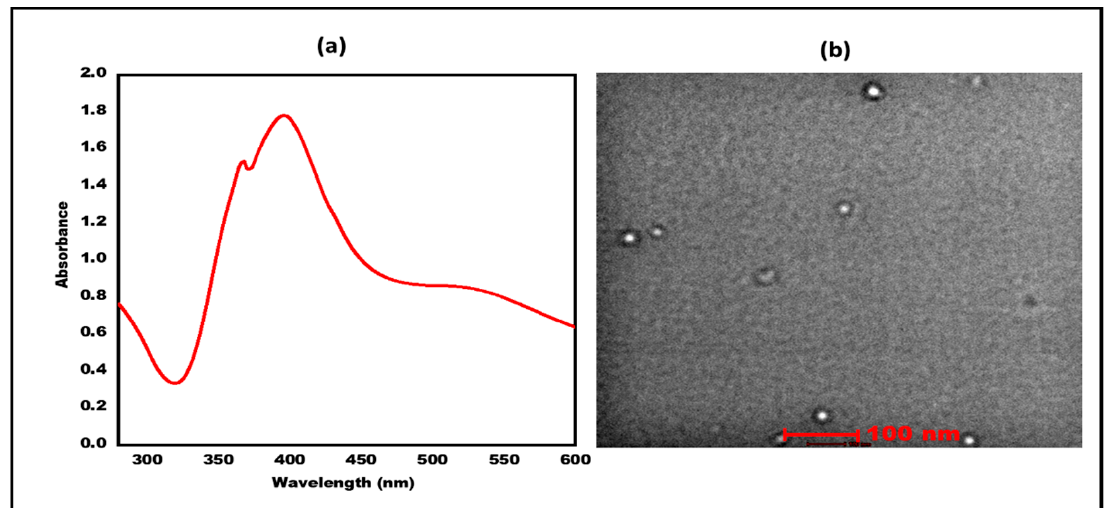
Figure 3. Characterization of Ag NPs ( a ) UV-Vis Spectroscopy ( b ) Transmission electron microscopy Figure (TEM).